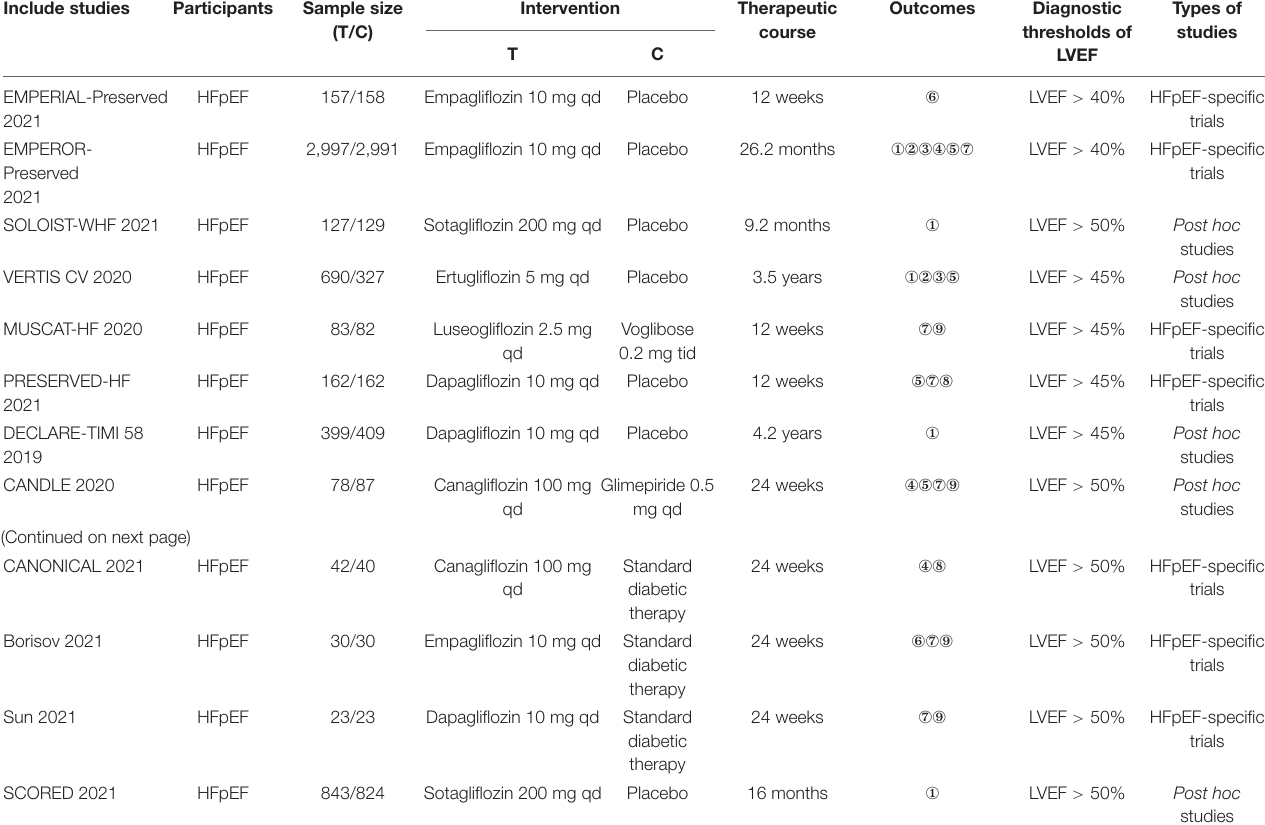
TABLE 1 | Characteristics of the included RCTs and the detail of